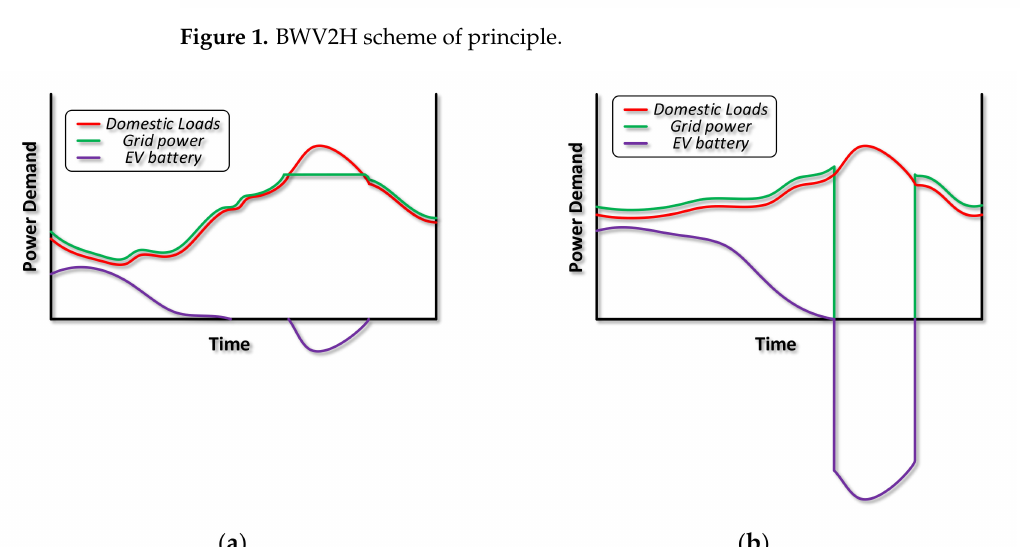
Figure 2. Application fields of V2H strategy: peak shaving ( a ) and power backup ( b